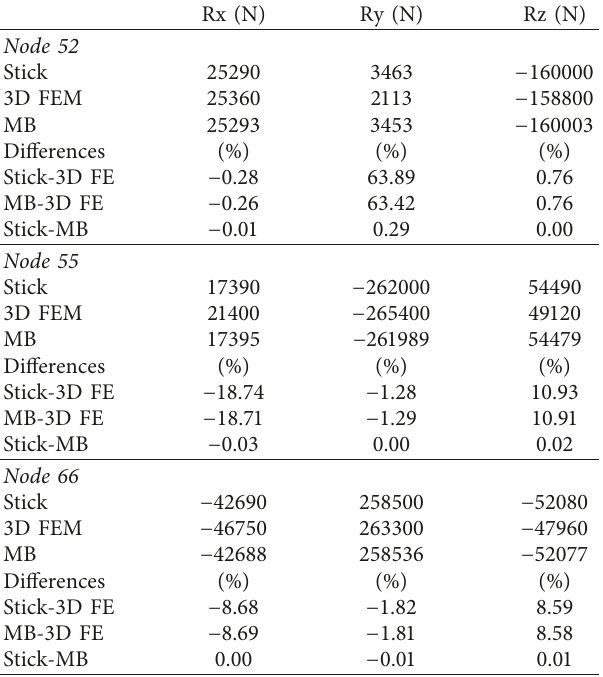
Figure 7: Boundary conditions (BCs) acting on the 3D full-FE model. Table 2: Reaction forces achieved for the main landing gear by the stick, 3D FE, and MB